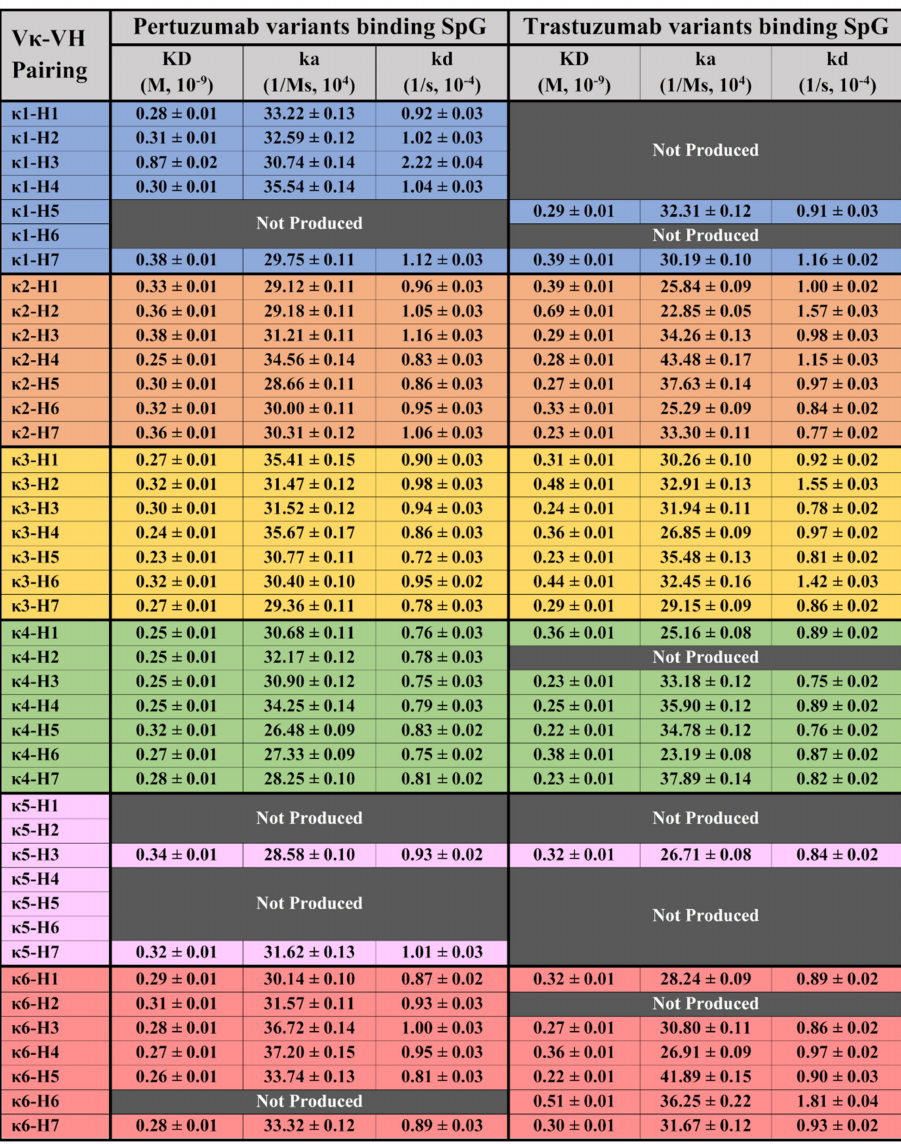
Figure 2. BLI measurements (KD, ka and kd) of Pertuzumab and Trastuzumab V κ 1–6 and VH1–7 variants binding to the immobilised SpG biosensor. “Not Produced” denotes insufficient antibody production for the variants despite numerous large-scale transfections. All readings were obtained from at least three antibody concentrations. The readings were the average of independent triplicates. The graphs are shown in Supplementary Figures